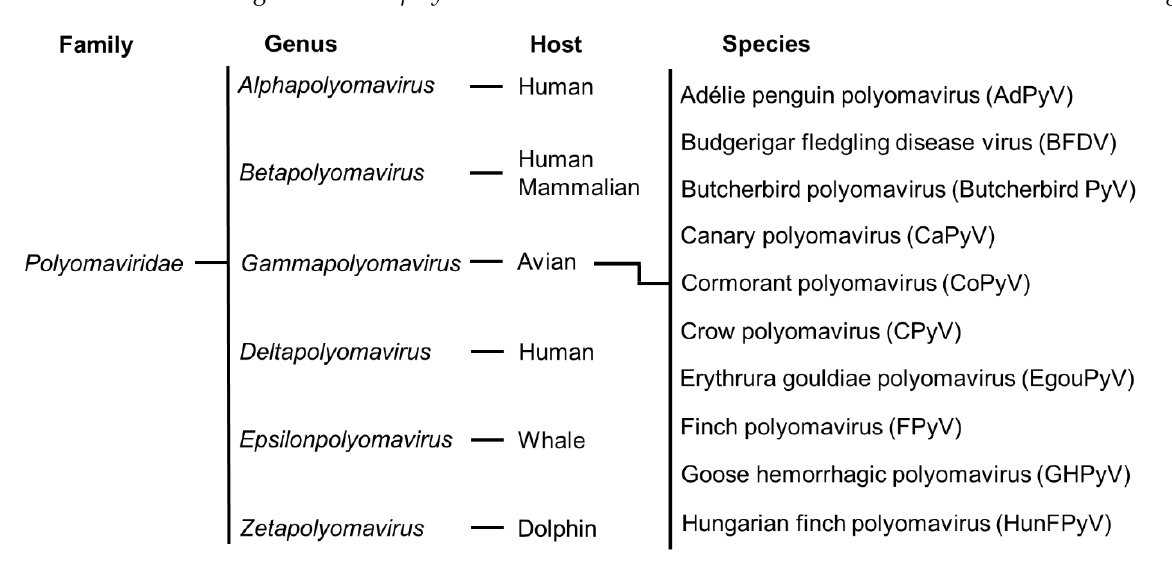
Figure 2. Classification of APVs under the genus Gammapolyomavirus . The Polyomaviridae family is generally divided into six genera. There are 10 APVs that belong to the genus Gammapolyomavirus .